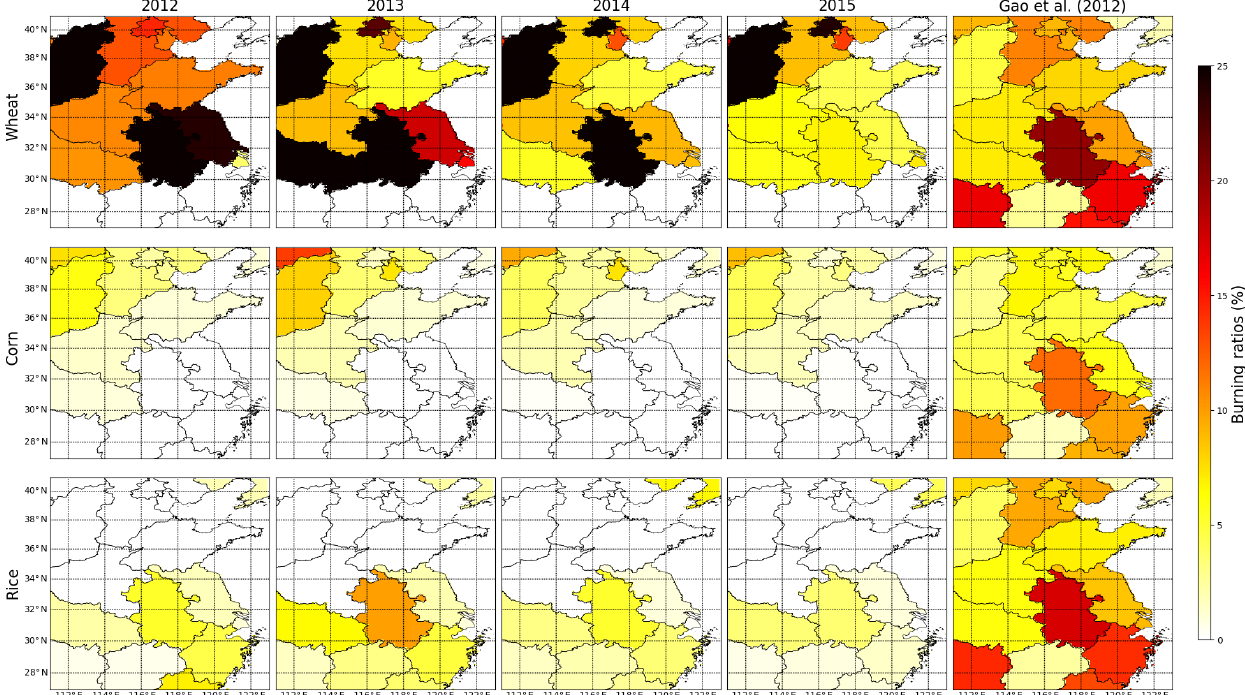
Figure 10. Temporal and spatial variability of province-specific percentages of crop residues burned in fields (burning ratio metrics) in eastern China. Data are calculated using crop yield estimates from the National Bureau of Statistics of China and the dry matter burned totals derived herein using our VIIRS-IM/Him DMB datasets for 2012–2015, then compared to the temporally invariant estimates provided by Gao et al. (2002, final column). The basic layer of country–province borders within this map was created using the Python Basemap